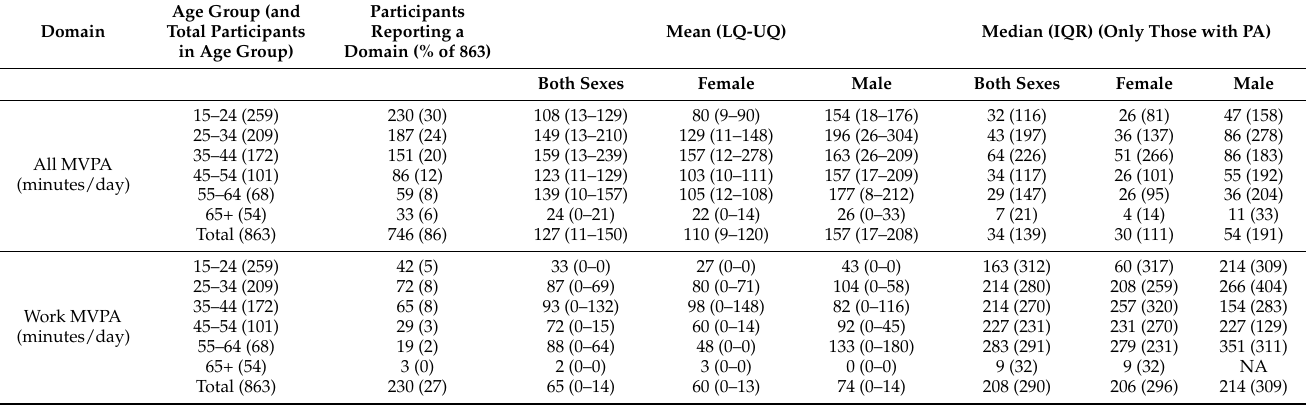
Table 3. Total and domain-specific durations of MVPA and sedentary behaviour by age and sex from GPAQ in Accra,